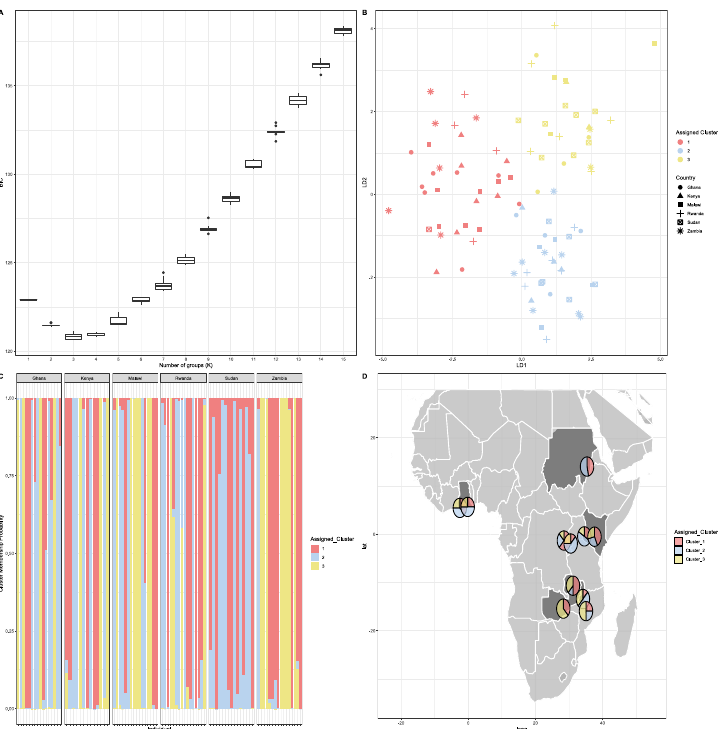
Figure 3. DAPC clustering (k = 3) and assignment of individuals from each country based on microsatellites. ( A ) The lowest BIC represents the best number of clusters, which here is 3. ( B ) The position of individuals on the first two principal components, and in ( C ) the membership probability of individuals to that cluster. ( D ) Assigned clusters for each sampling location across